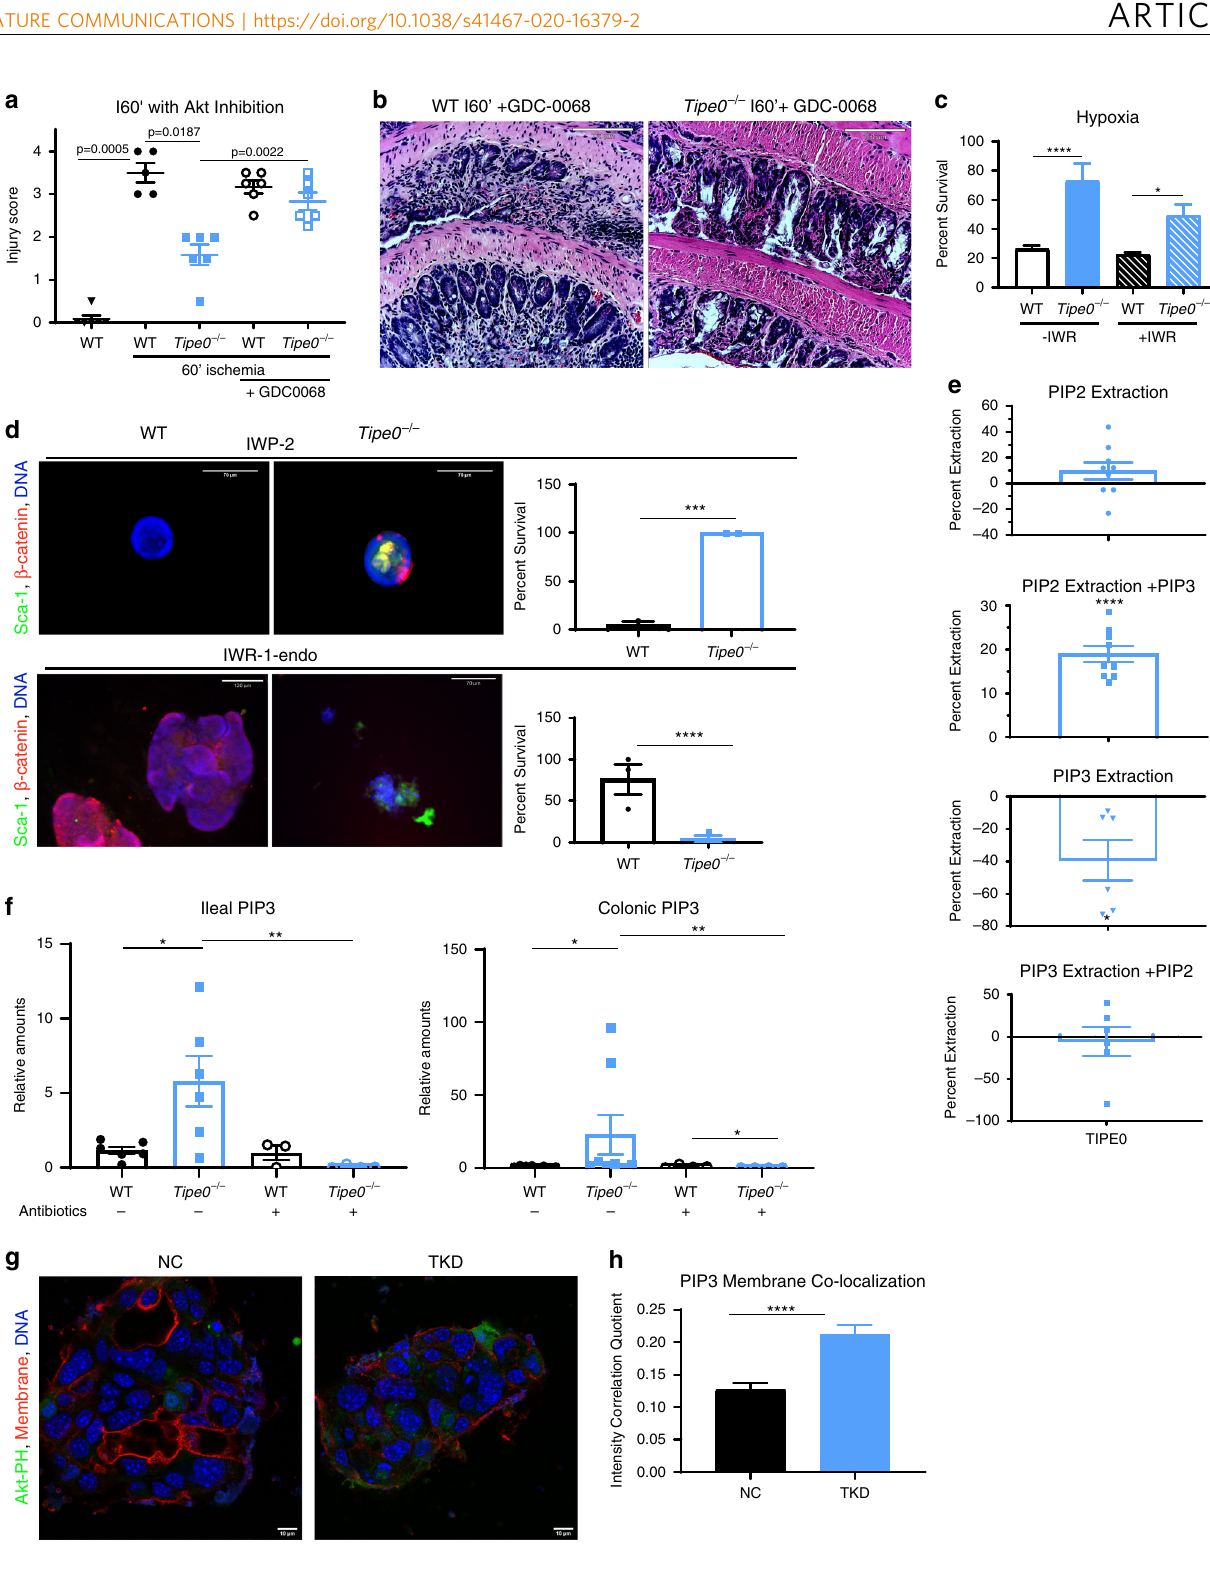
RNAScope . smFISH (RNAScope) was performed according to the manufacturer's recommendations, using their pre-made probes. Bulk RNASeq . Enteroids were isolated as described above. RNA-Seq was per- formed by BGI (Shenzhen, China). Total RNAs were extracted from samples, then mRNA and non-coding RNAs were enriched by removing rRNA from the total RNA with kit. By using the fragmentation buffer, the mRNAs were fragmented into short fragments (about 200 – 500 nucleotides (nt)), then the fi rst-strand cDNA